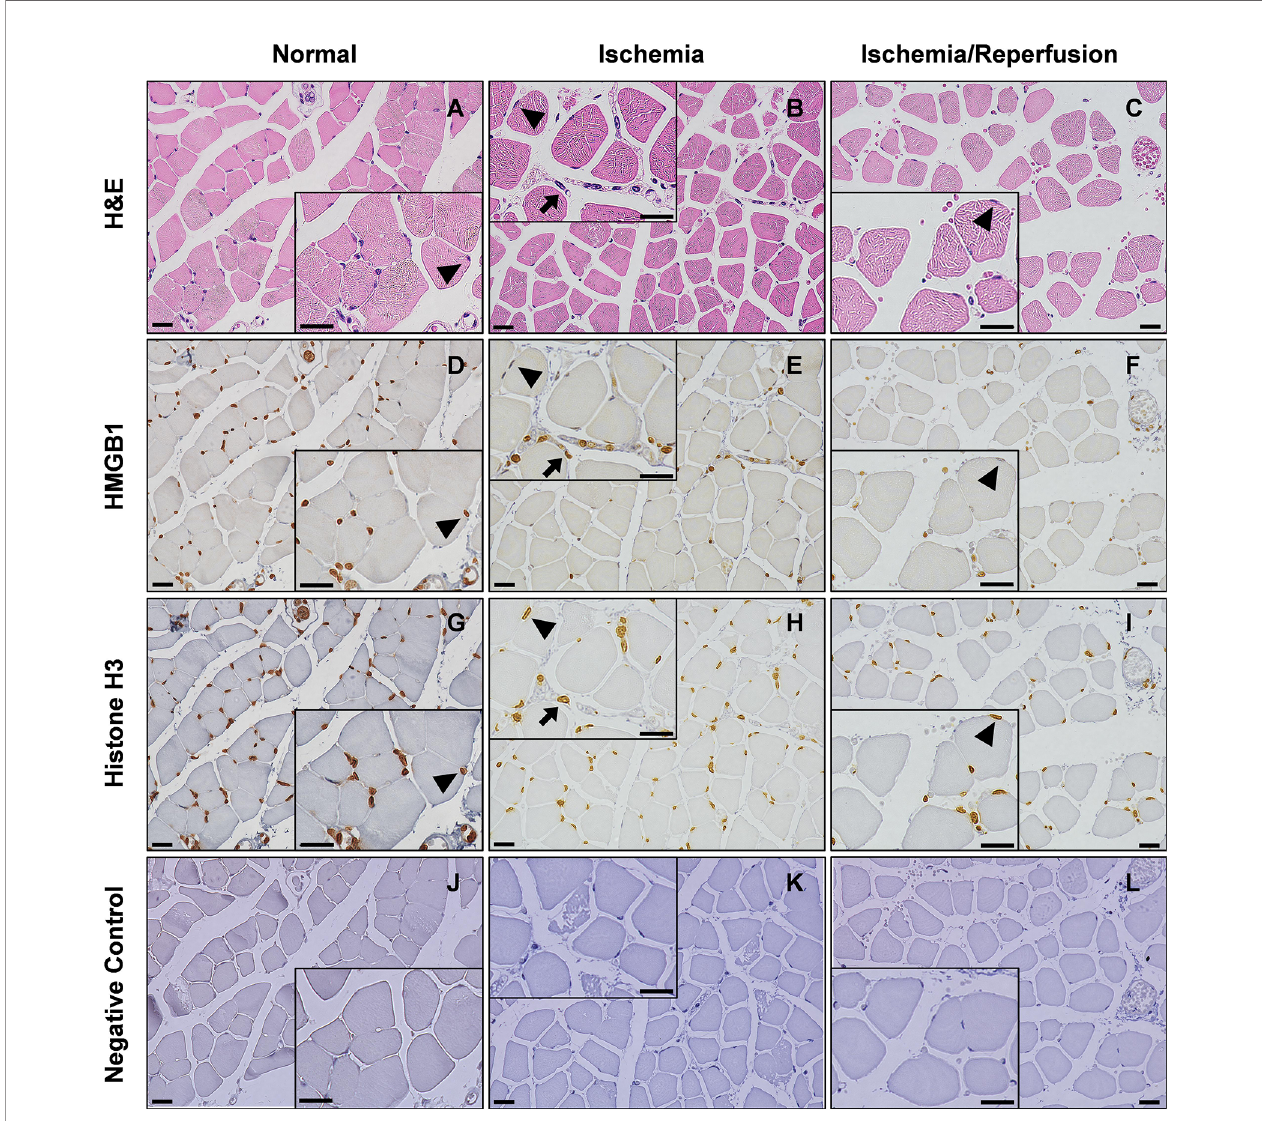
FIGURE 3 | Translocation of HMGB1 after I/R in mice. Light microscopy view of the hindlimb muscle. Serial sections of gastrocnemius muscles were stained with H&E (A – C) , anti-HMGB1 antibodies (D – F) , anti-histone H3 antibodies (G – I) , or non-immune negative control (J – L) in normal, 12 h ischemia, and 12 h I/R mice. Insets show magni fi ed images of skeletal muscle cells and leukocytes. Arrow heads indicate that HMGB1 and histone H3 are abundantly expressed in the nucleus of normal skeletal muscle cells while HMGB1, but not histone H3, disappears from the nucleus after ischemia or I/R. Arrows indicate that HMGB1 and histone H3 are abundantly expressed in the nucleus of leukocytes even after ischemia. The scale bars indicate 20 m m. Representative images of two or more independent experiments are